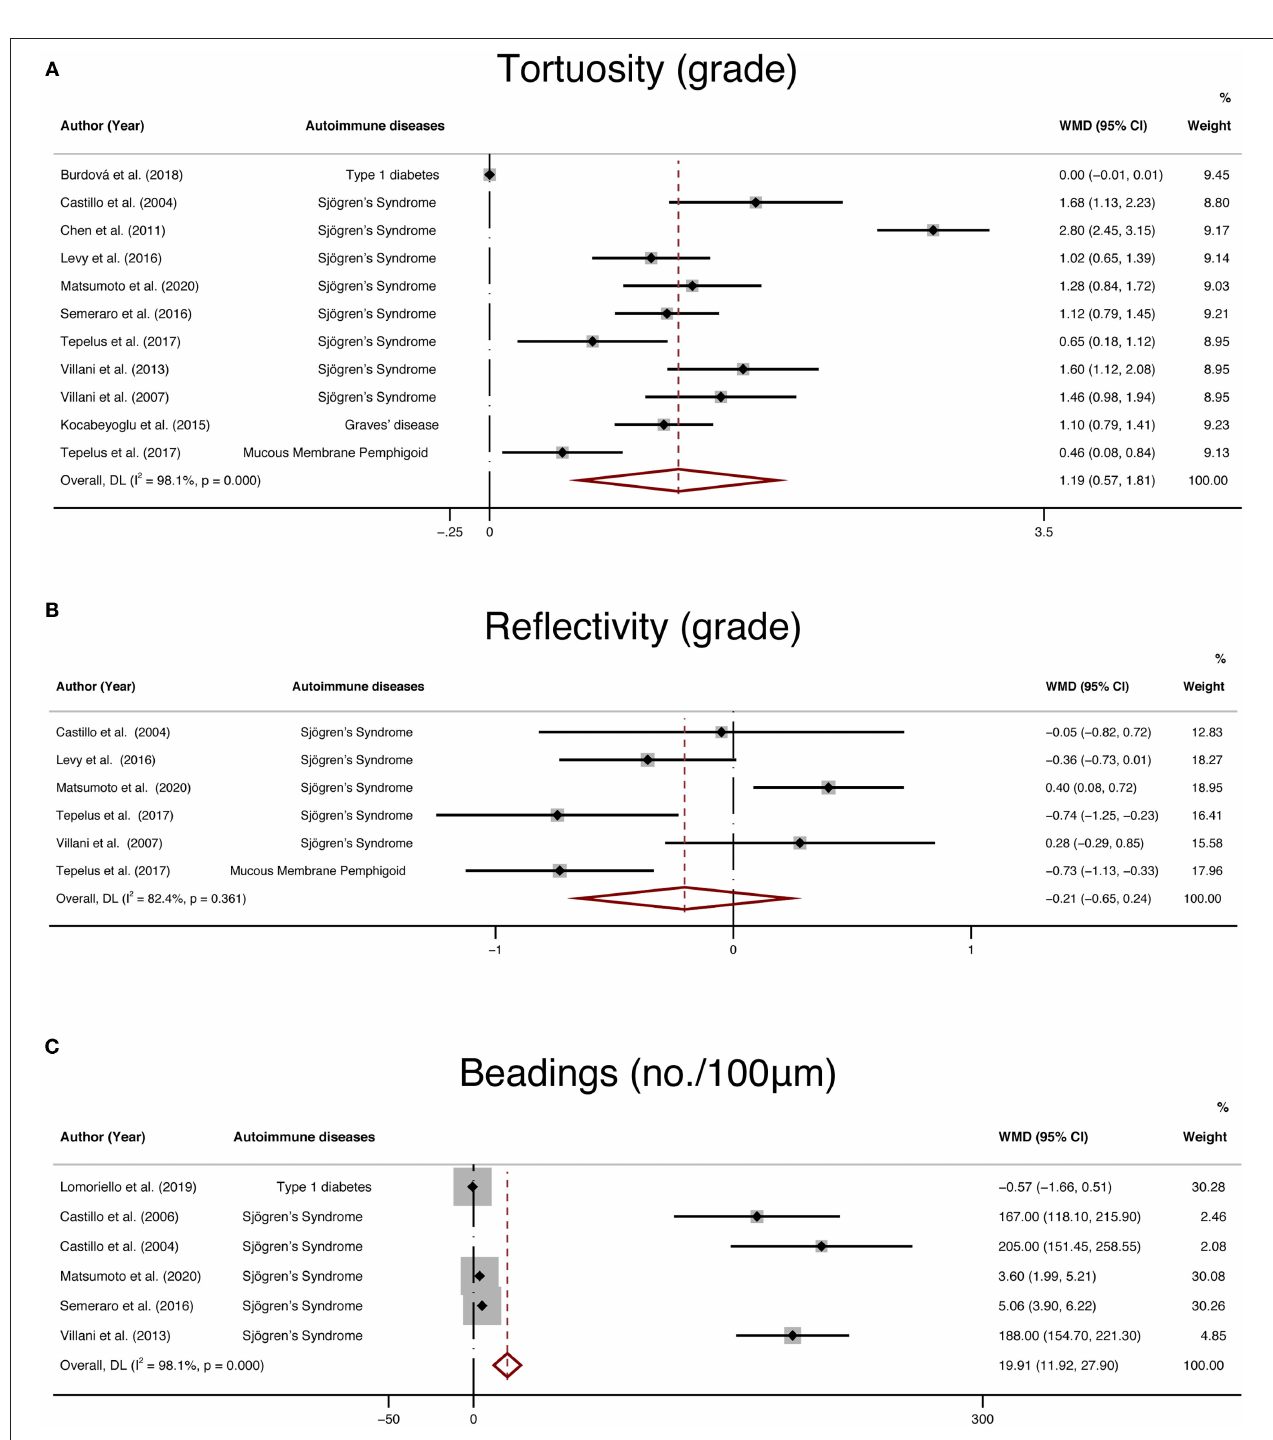
FIGURE 9 | Forest plot of the WMD of tortuosity (A), reflectivity (B), and beadings (C) between the NNAI group and the control group. WMD, weighted mean difference; CI, confidence interval; NNAI, non-neurological autoimmune (diseases).